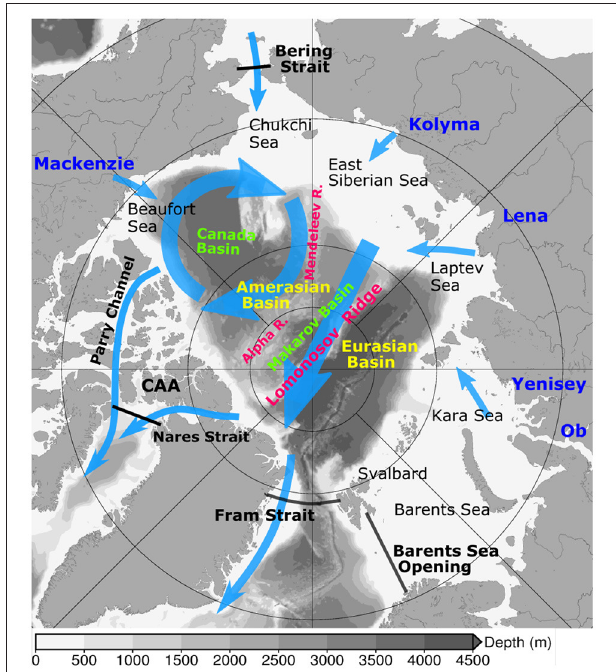
FIGURE 1 | Schematic of Arctic upper ocean circulation (blue arrows). The background gray color shows bottom bathymetry. The Arctic gateways are indicated with black lines. CAA stands for Canadian Arctic Archipelago.